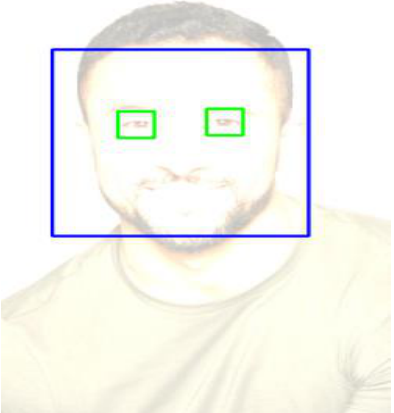
Figure 19. Again slightly increasing the brightness of Figure 17.